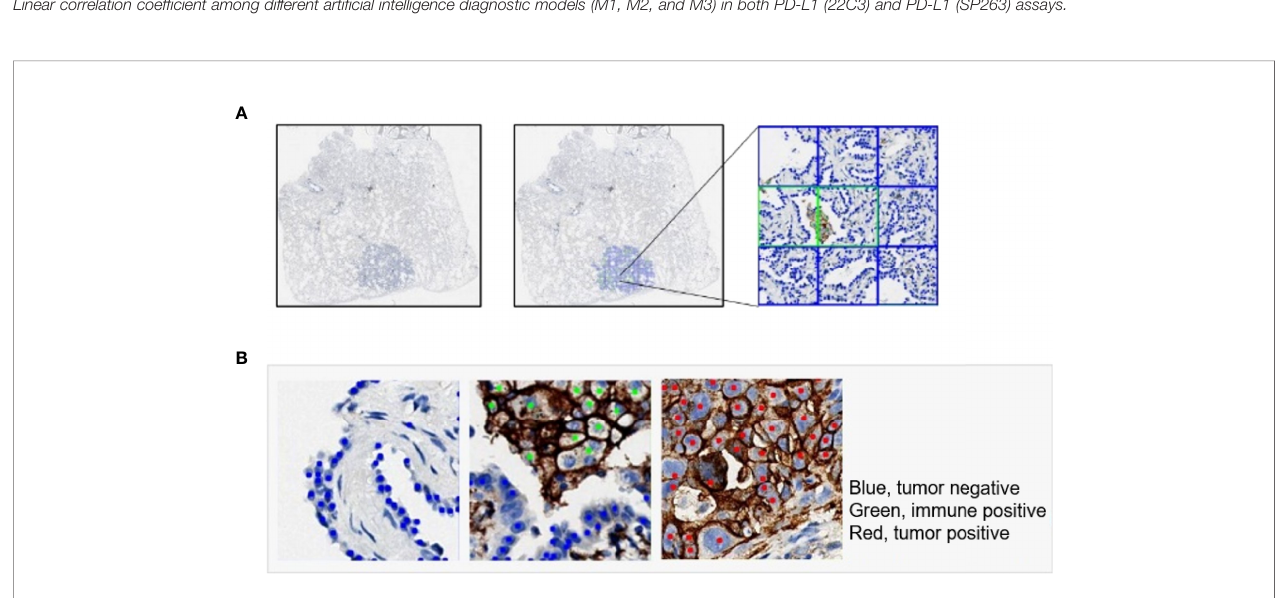
( Figure 7B ) (M2: speci fi city, 0.9024; sensitivity, 0.9615; precision,